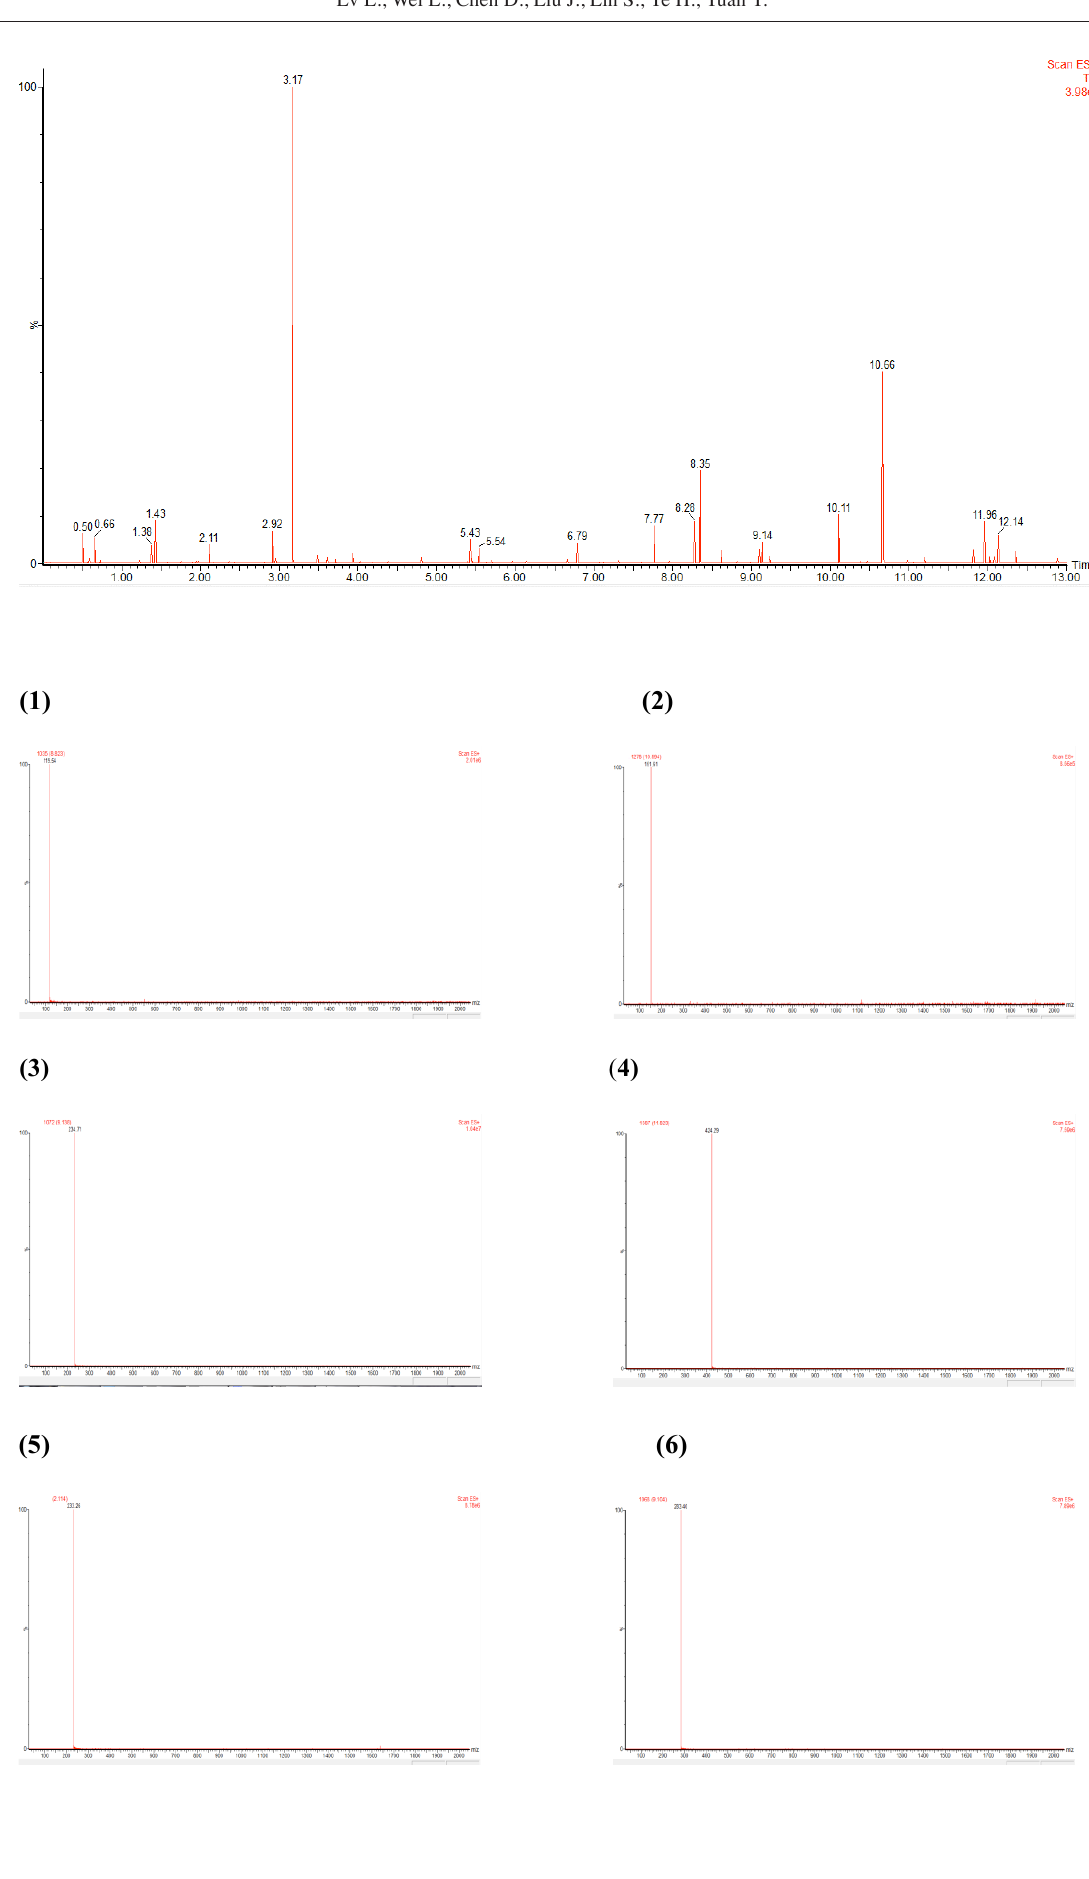
concentration (X 2 /%); (B) Contour plot graph showing interaction between ultrasonic power 428 (X 1 /W) and solvent-to-material ratio (X 3 /mL/g); (C) Contour plot graph showing interaction 429 between ethanol concentration (X 2 /%) and solvent-to-material ratio (X 3 /m/g). 430